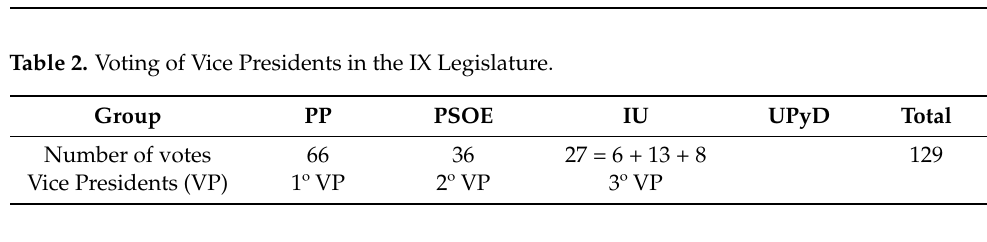
Table 3. Voting of Secretaries in the IX